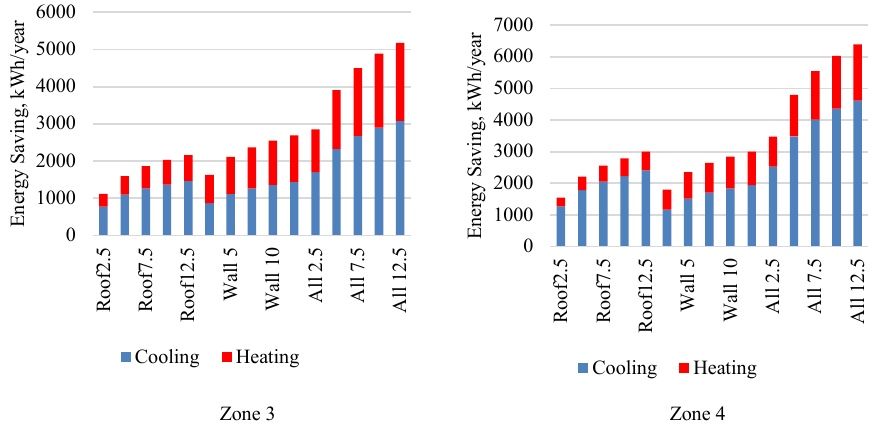
Fig. 3. Annual cooling and heating energy saving from thermal insulation in different climate zones.